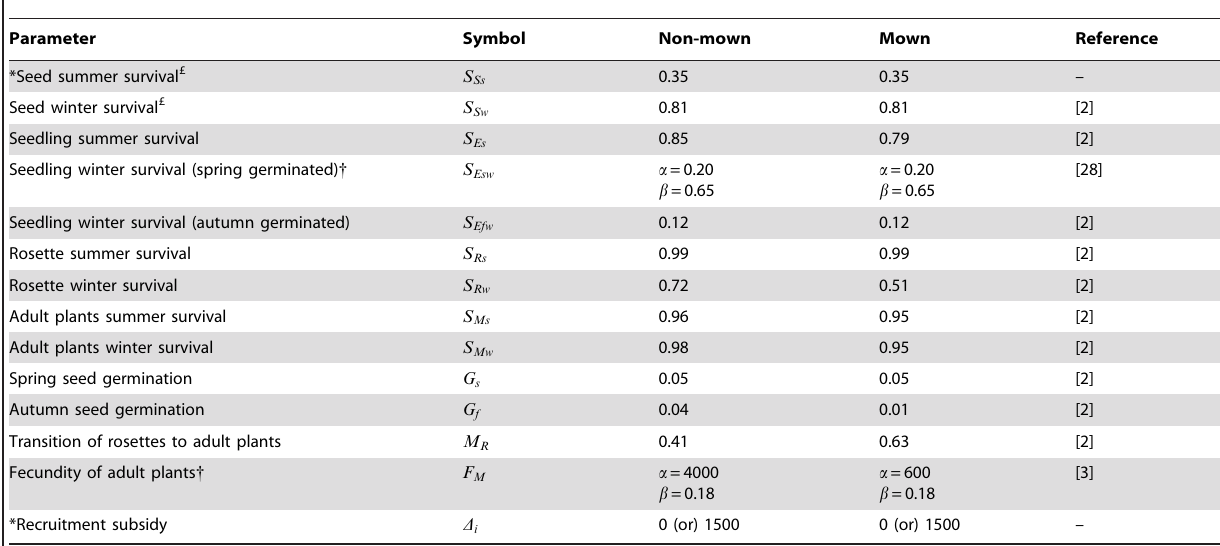
Table 1. The parameter values used in the population dynamic model for roadside